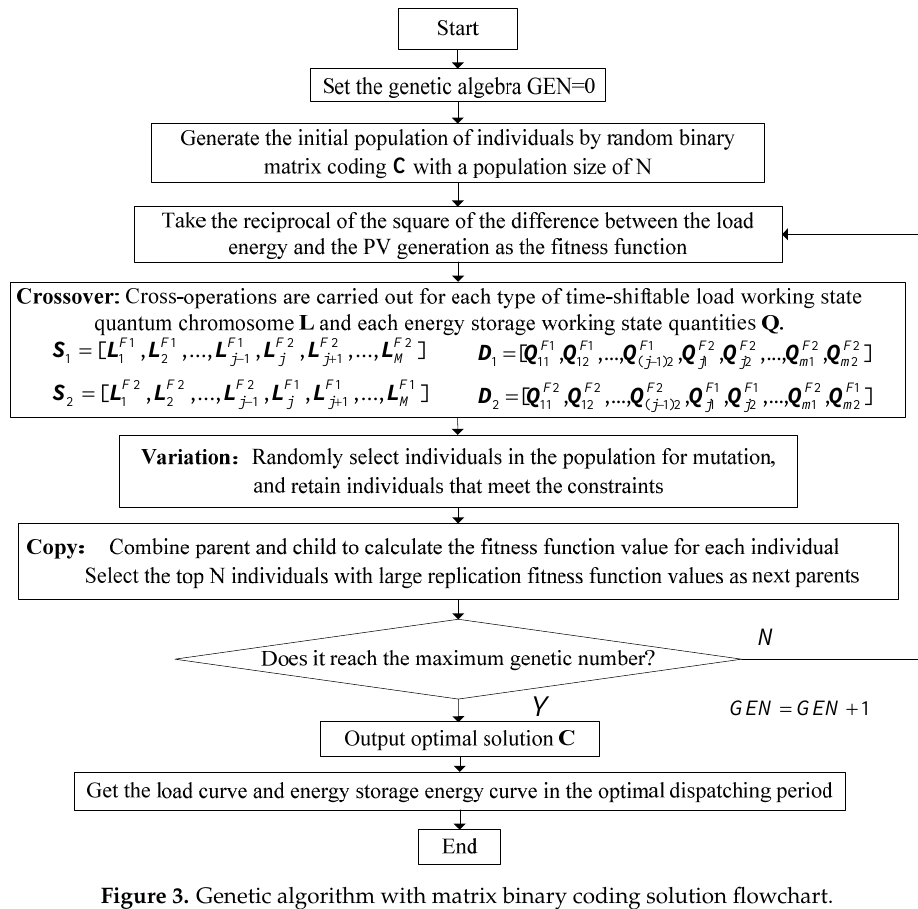
Figure 3. Genetic algorithm with matrix binary coding solution flowchart.